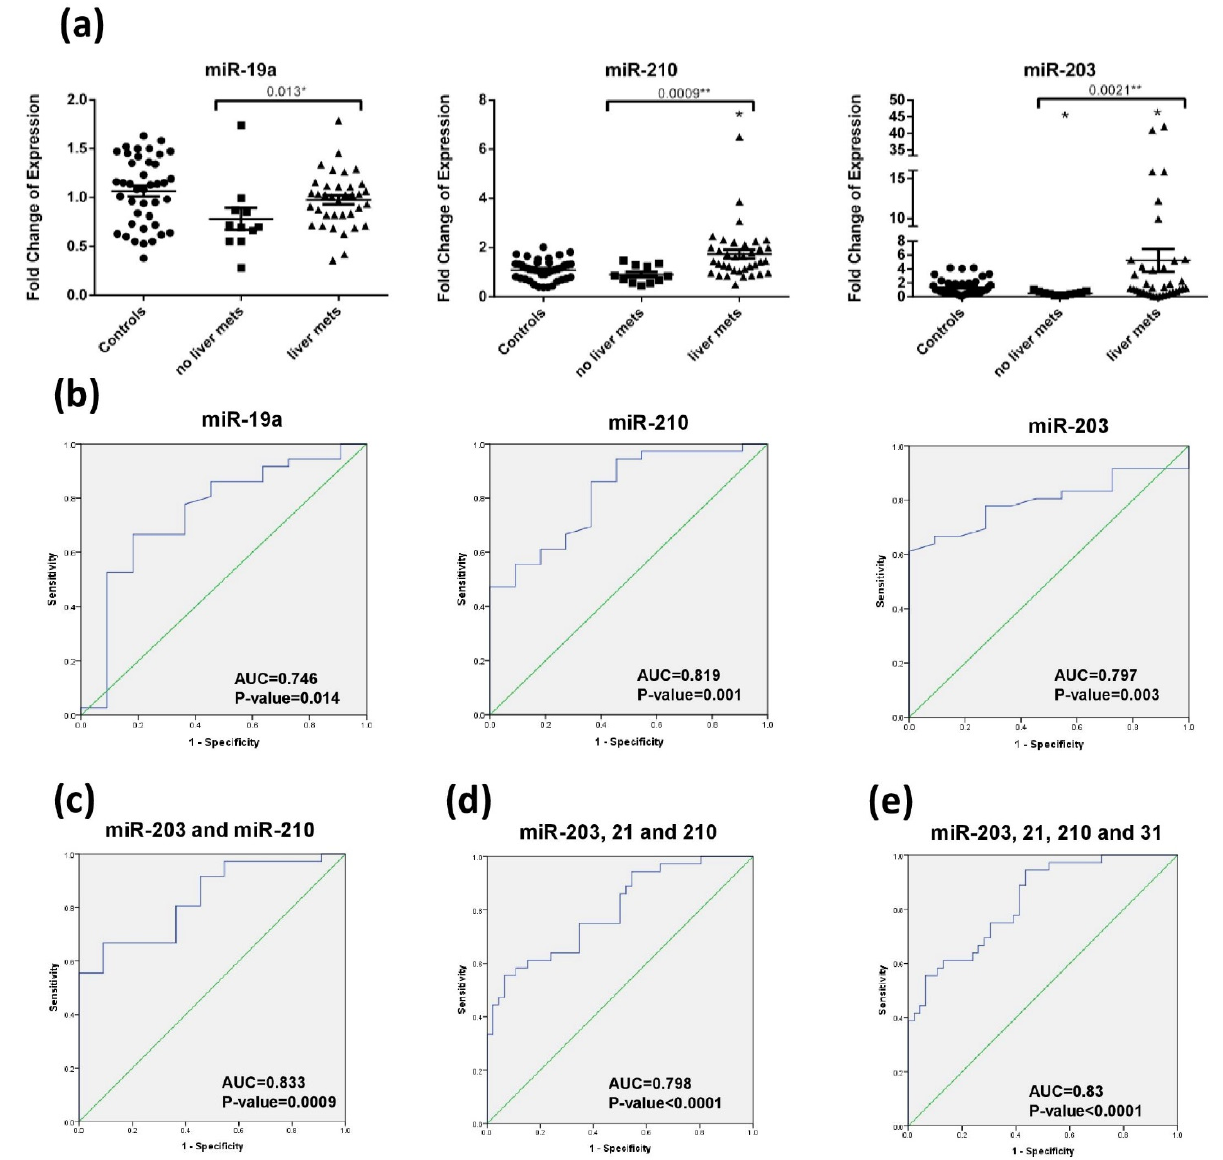
Figure 4. Circulating miRNA for liver metastasis in CRC patients. ( a ) miR-19a, miR-210, miR-203 expression in CRC patients with liver metastasis vs. metastasis to other sites. The dotplots represent the mean (middle line) and the standard error of mean (error bars). * denotes p -value < 0.05 according to Wilcoxon’s signed-rank test. * above line denotes p -value < 0.05 and ** above line denotes <0.01 according to Mann–Whitney test. mets: metastasis ( b ) ROC curve of miR-19a, miR-210, and miR-203 to differentiate CRC patients with liver metastasis from other metastasis. ( c ) ROC curve of combination miR-210 and miR-203 to differentiate CRC patients with liver metastasis from other metastasis. ( d ) ROC curve of combination miR-203, miR-21, and miR-210 to differentiate CRC patients with liver metastasis to healthy subjects and those CRC with no liver metastasis. ( e ) ROC curve of combination of miR-203, miR-21, miR-210, and miR-31 to differentiate CRC patients with liver metastasis to healthy subjects and those CRC with no liver metastasis. Table 3. Diagnostic parameters to evaluate individual and combined miRNA for liver metastasis in CRC patients. AUC: area under the curve, SE: standard error of mean, PPV: positive predicted value, NPV: negative predicted value, and DA: diagnostic accuracy.